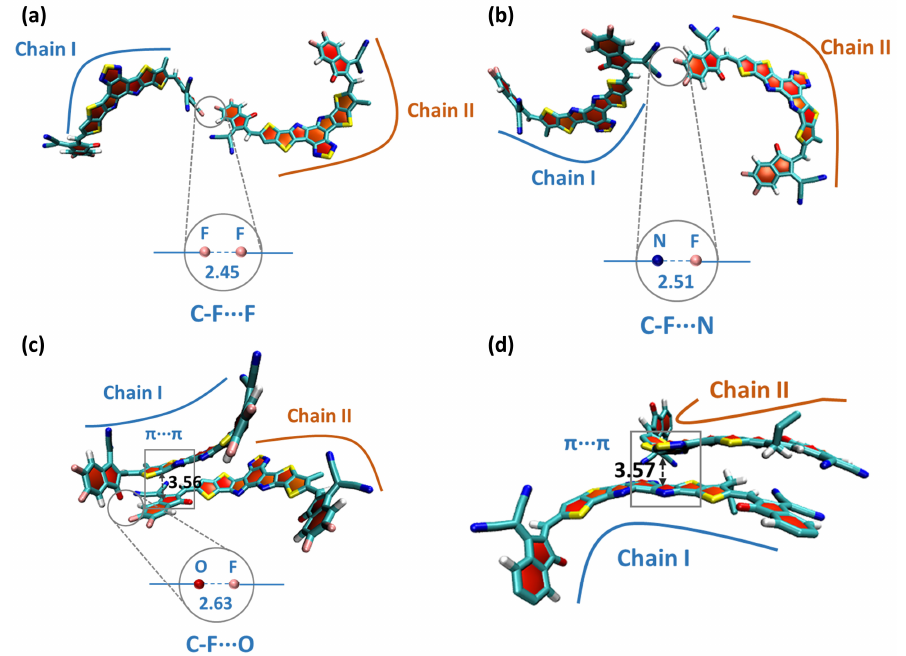
Figure 5. Representative configurations of the Y6 dimer ( a ) containing C − F · · · F halogen bonding, Figure 5 . Representative configurations of the Y6 dimer ( a ) containing C − F···F halogen bonding, ( b ) ( b ) C − F · · · N halogen bonding, ( c ) C − F · · · O halogen bonding and π · · · π stacking in Y6 neat films; C − F···N halogen bonding, ( c ) C − F···O halogen bonding and π ··· π stacking in Y6 neat films; and ( d ) and ( d ) the Y5 dimer only involving π · · · π stacking in Y5 neat the Y5 dimer only involving π ··· π stacking in Y5 neat films.